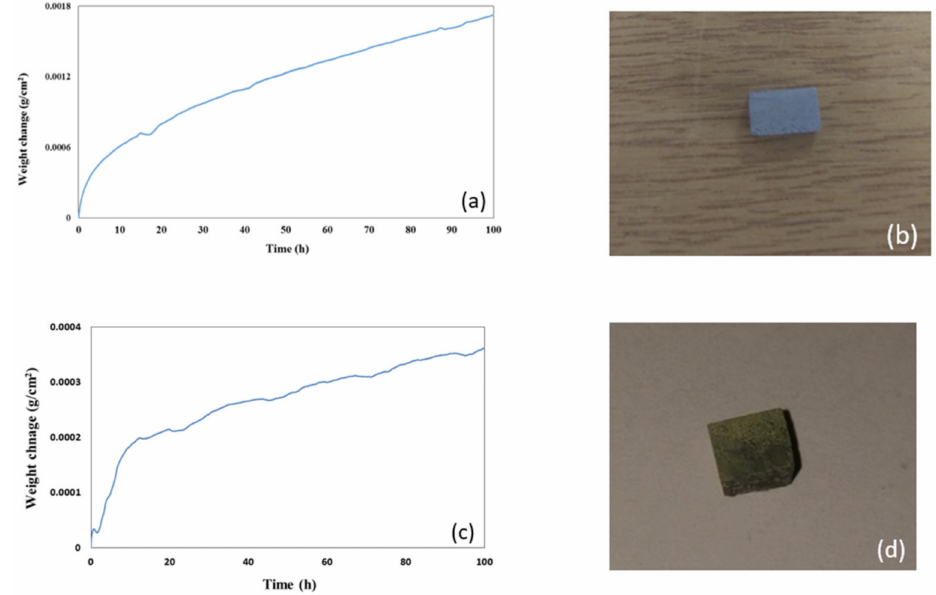
Figure 8. Weight change data and oxidised specimens after isothermal oxidation at 1200 ◦ C ( a , b ) alloy MG5, ( c , d ) alloy